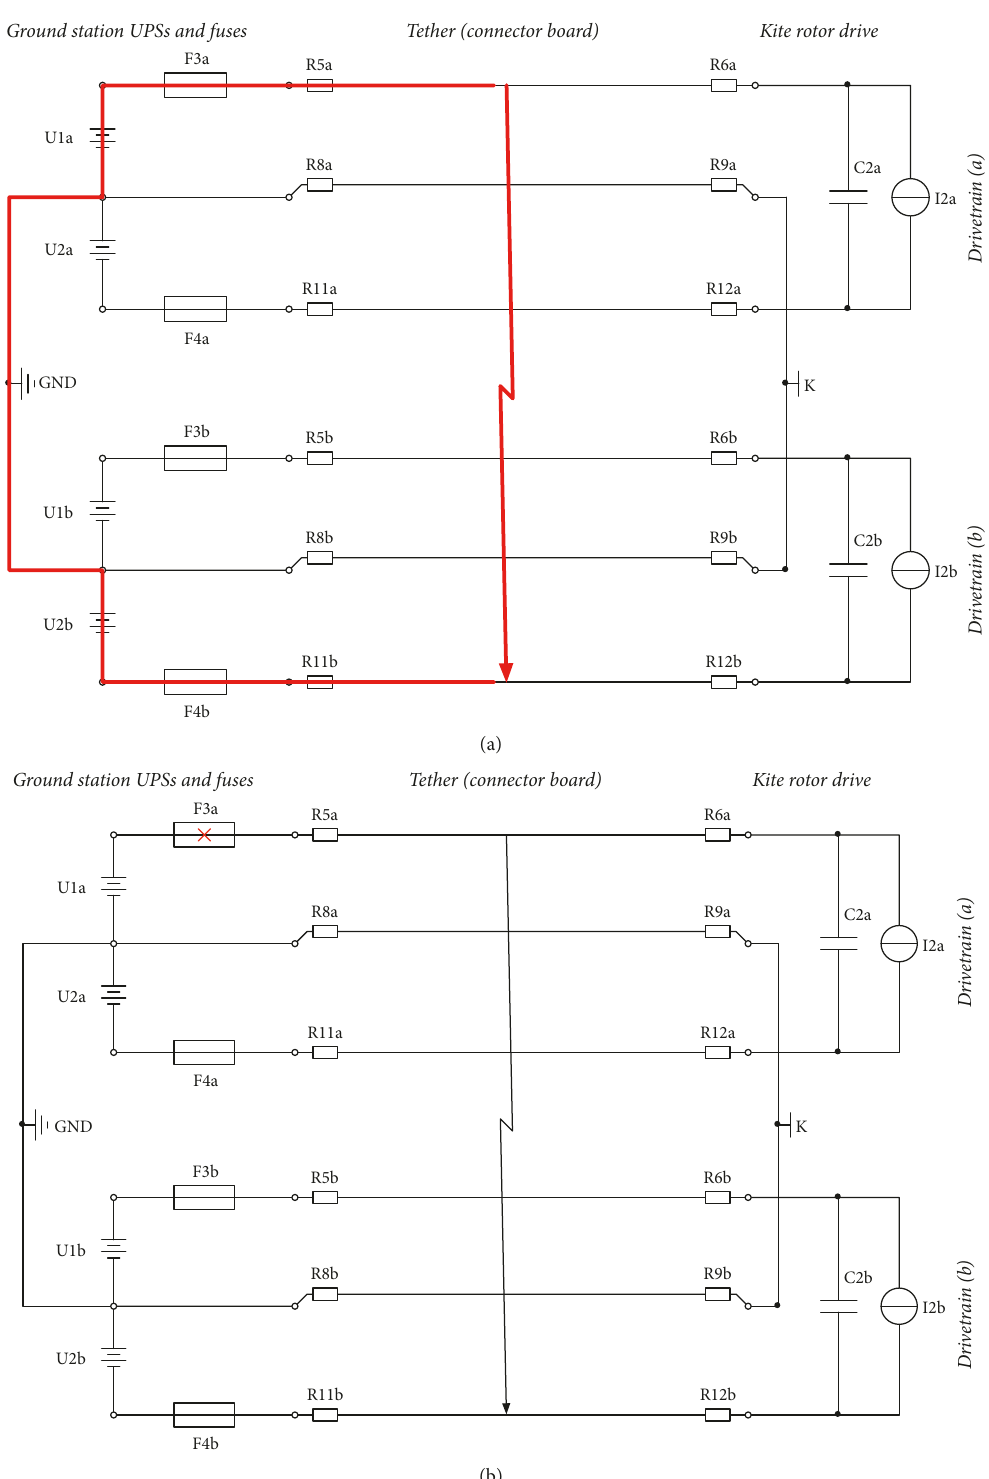
Figure 26: Investigation of short circuit fault S7 for the demonstrator: (a) short circuit currents driven by UPSs and (b) circuit after fuse